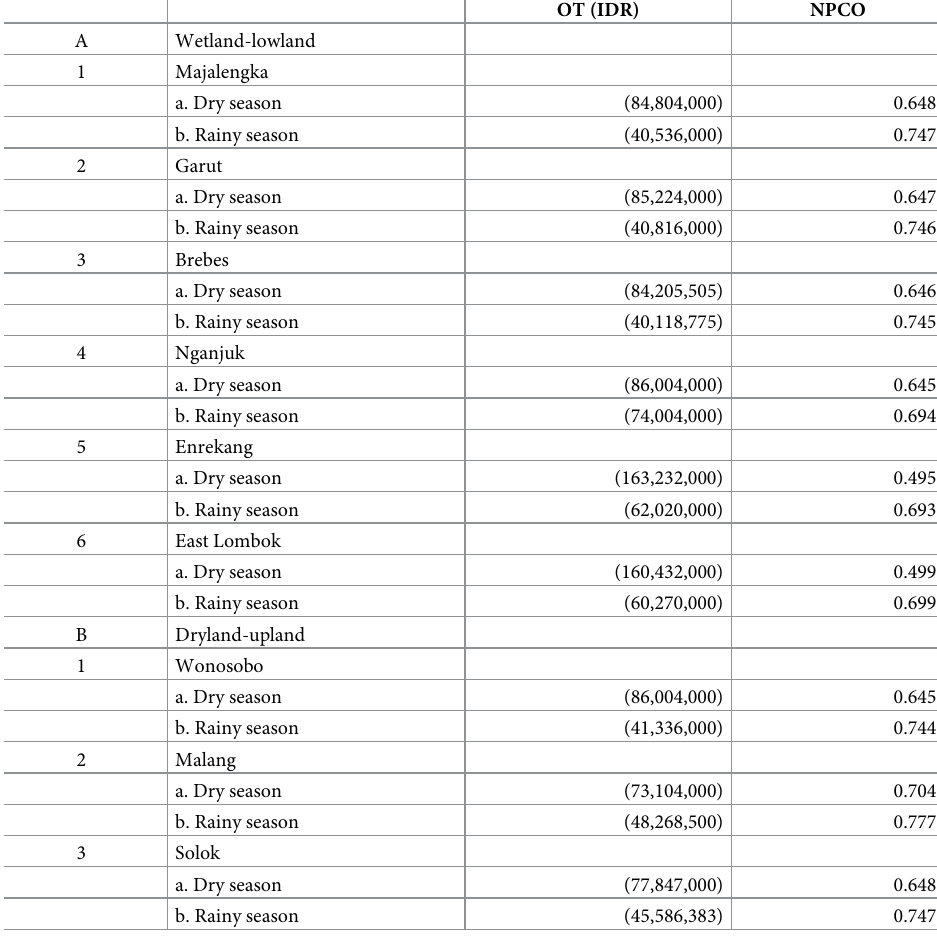
Table 4. Values of OT and NPCO of shallot farming per ha per season in Indonesia’s shallot production centers, dry season 2019 and rainy season 2019/2020.